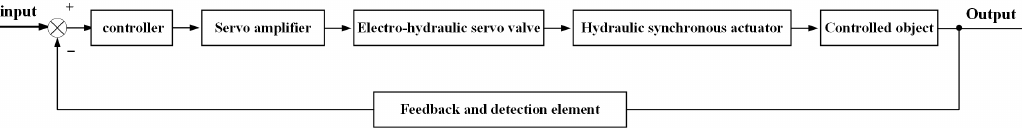
Figure 8. Block diagram of electro-hydraulic servo hydraulic synchronization control system.